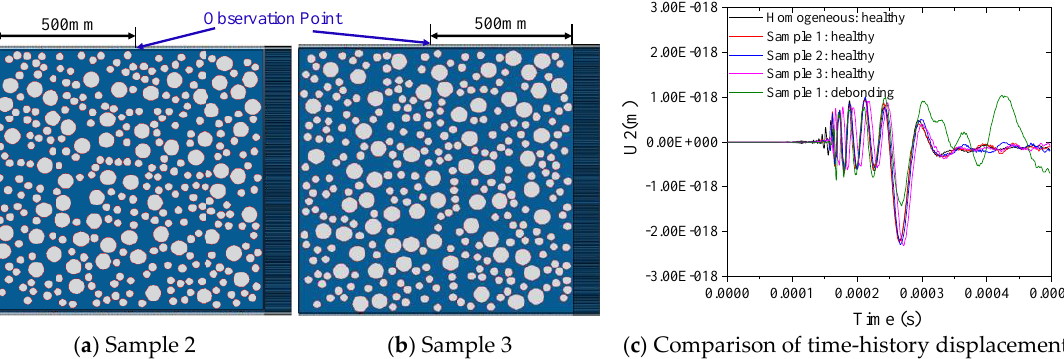
Figure 8. Influence of mesoscale structure variation on the propagation process of the surface wave.